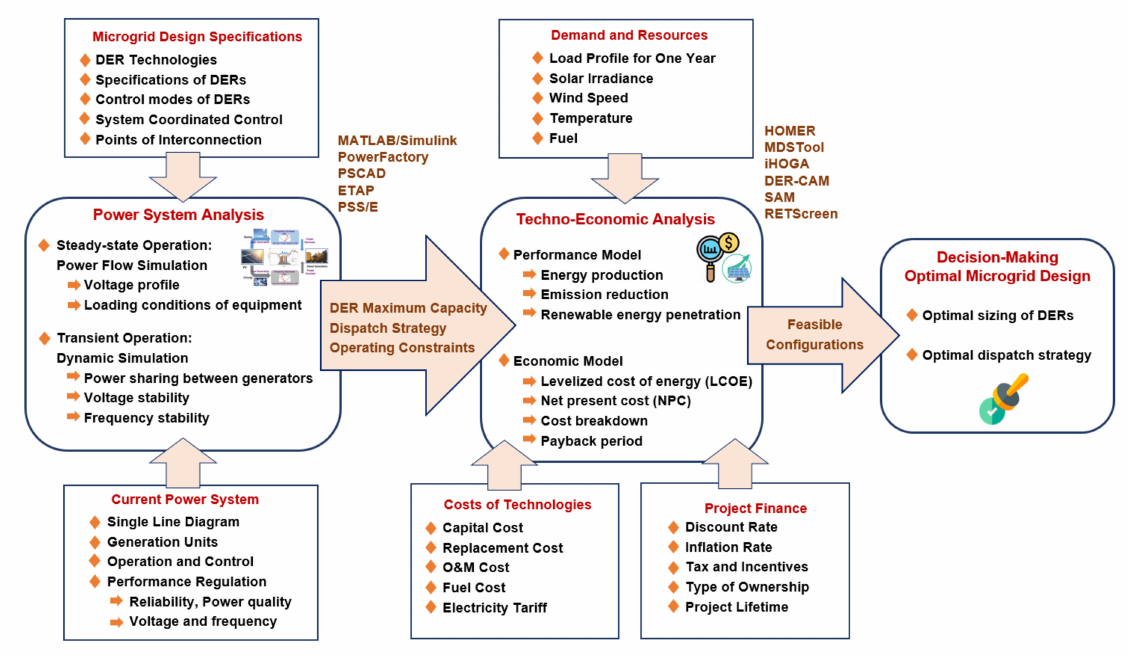
Figure 1. Proposed microgrid design